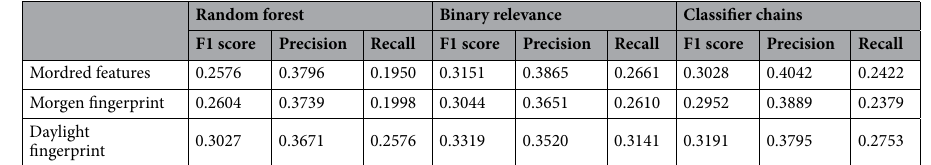
Table 4. Showing micro averaged precision, recall, and F1cross-validation scores for each featurization and model approach.